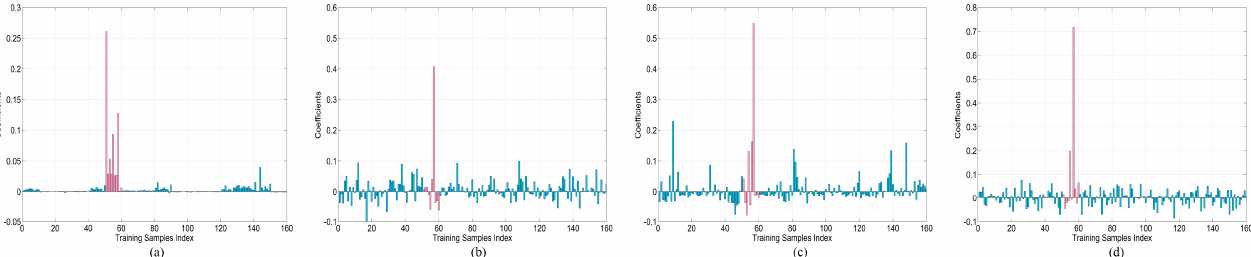
Figure 11. Reconstruction residuals of a test sample from class 6 in the Indian Pines data set using 10 training samples per class for the MFCARC algorithm. ( a ) Spectral. ( b ) Gabor. ( c ) DMP. ( d ) LBP.